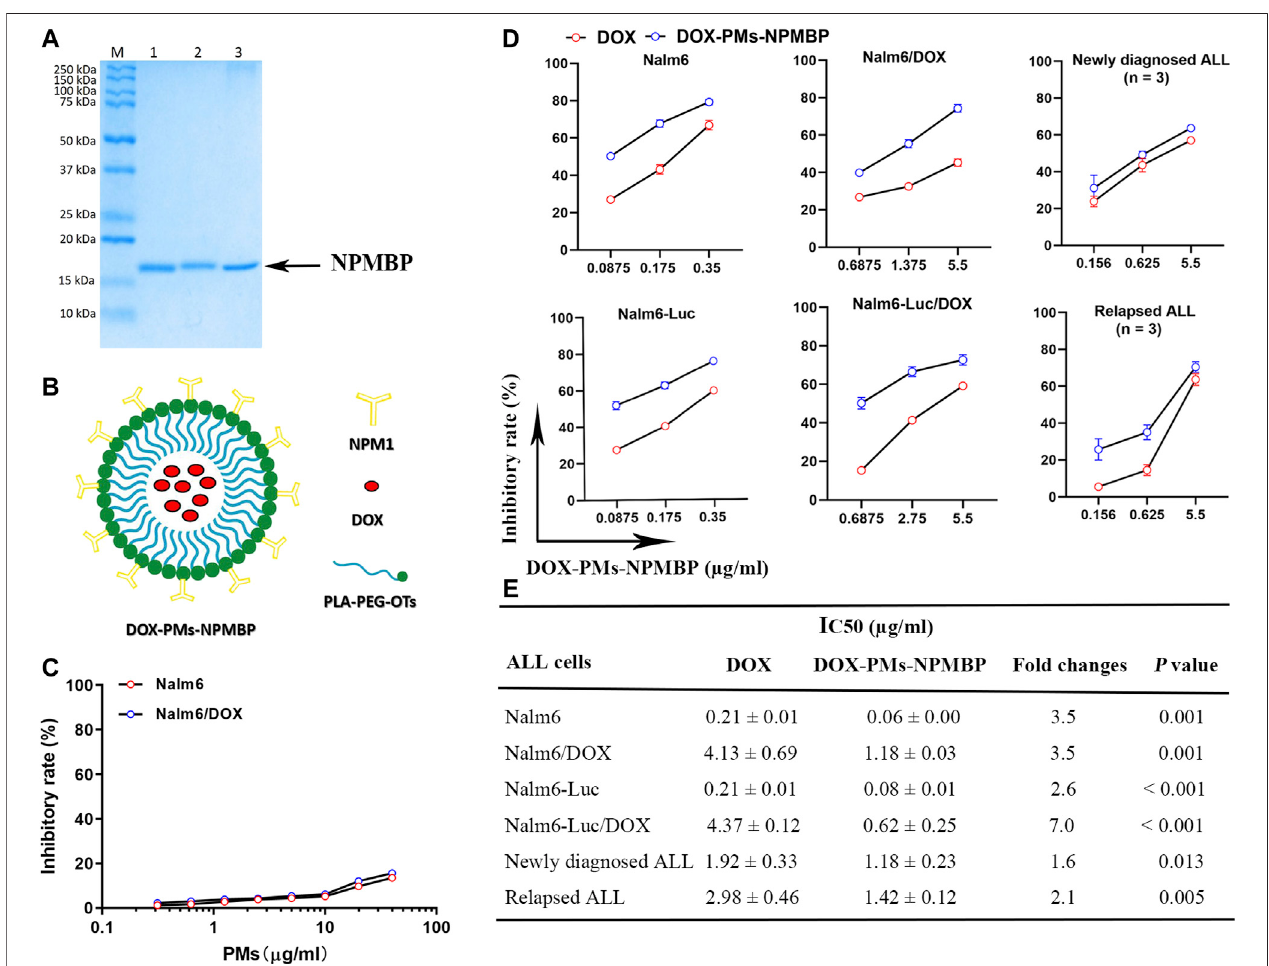
FIGURE 1 | IC50 values of DOX-PMs-NPMBP on multiple ALL cell lines and different primary ALL cells from patients as measured by MTT assay. (A) RepresentativegeldemonstratingtheexpectedmolecularweightandpurityofNPMBP. (B) SchematicillustrationofthestructureofDOX-PMs-NPMBP. (C)